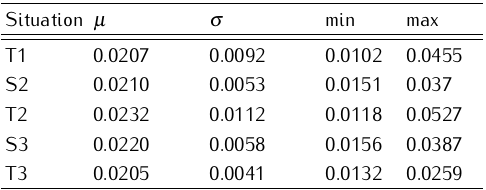
Table 5. The average, minimum and maximum speech energy between the participants and the researcher during T1-T3 and